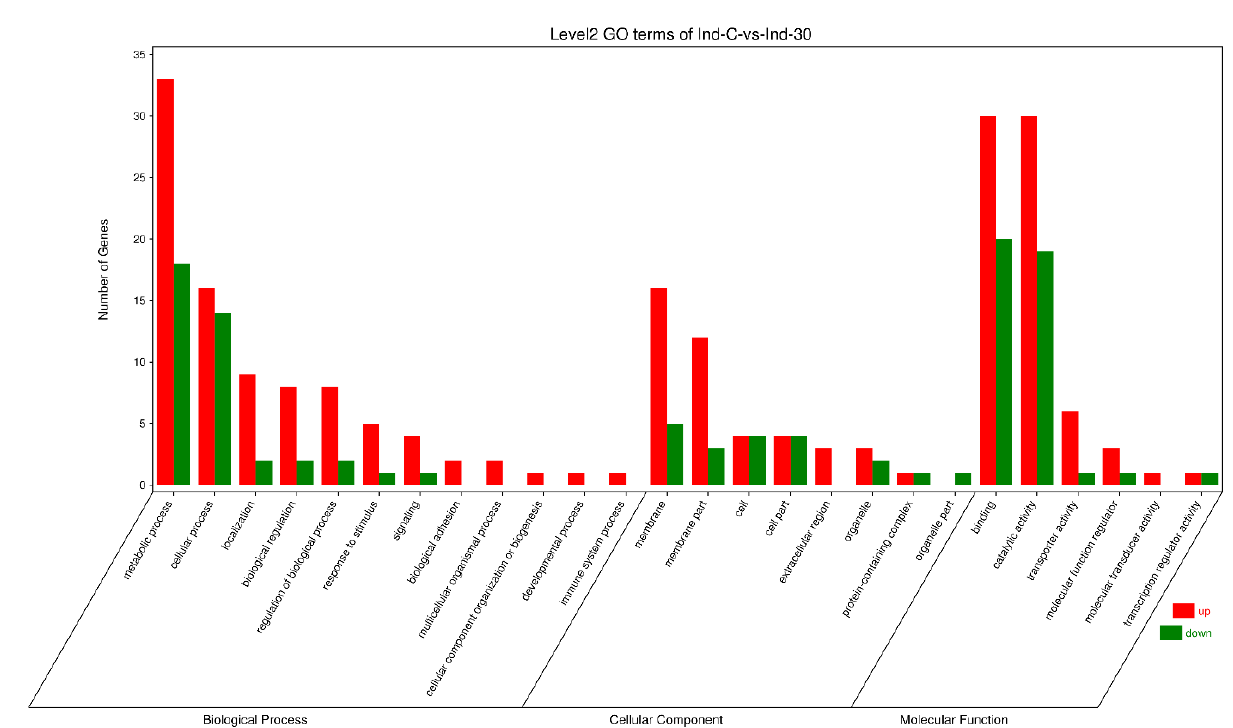
Figure 4. DEGs of S. invicta enriched in gene ontology (GO) following sublethal indoxacarb exposure (after 24 h). The x-axis denotes biological process (BP), cellular component (CC), and molecular function sub-Go terms (MF). The y-axis shows the DEGs participating in each term.